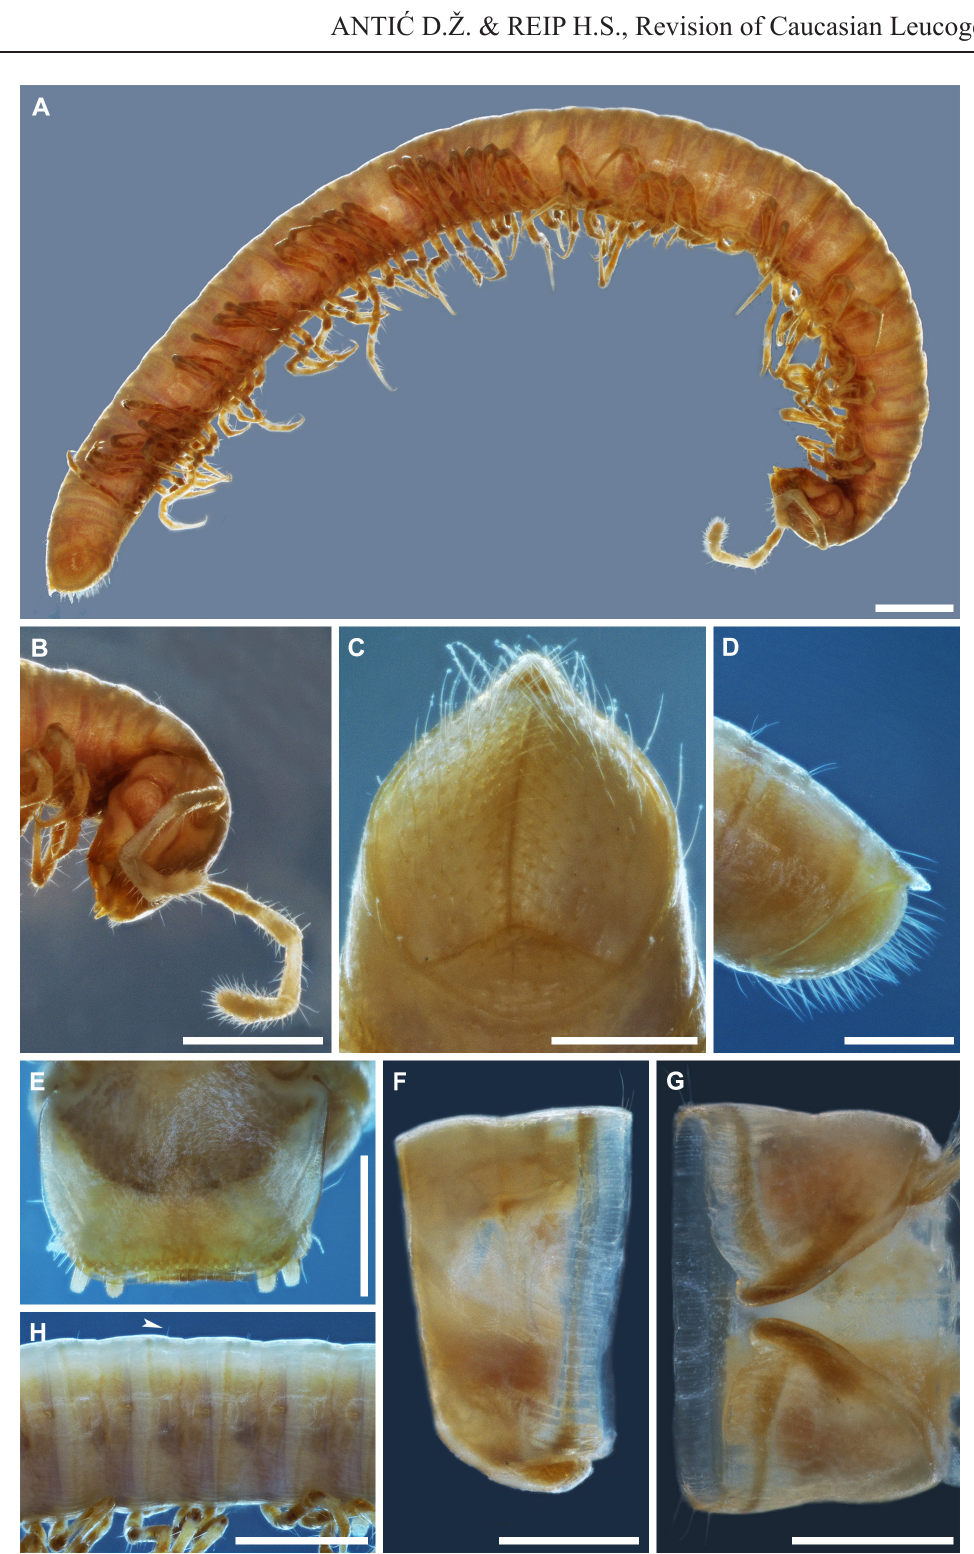
Fig. 47. Leucogeorgia turbanovi sp. nov., types from Pechalnaya Cave (ZMUM). A . Holotype ♂, habitus, lateral view. B . Holotype, anterior part of body, lateral view. C . Paratype ♀, telson, posterior view. D . Holotype, posterior part of body, lateral view. E . Paratype ♂, head, dorsal view. F . Paratype ♂, body ring 7, lateral view. G . Paratype ♂, body ring 7, ventral view. Arrow indicates metazonal seta. Scale bars: A–B, H = 1 mm; C–G = 0.5